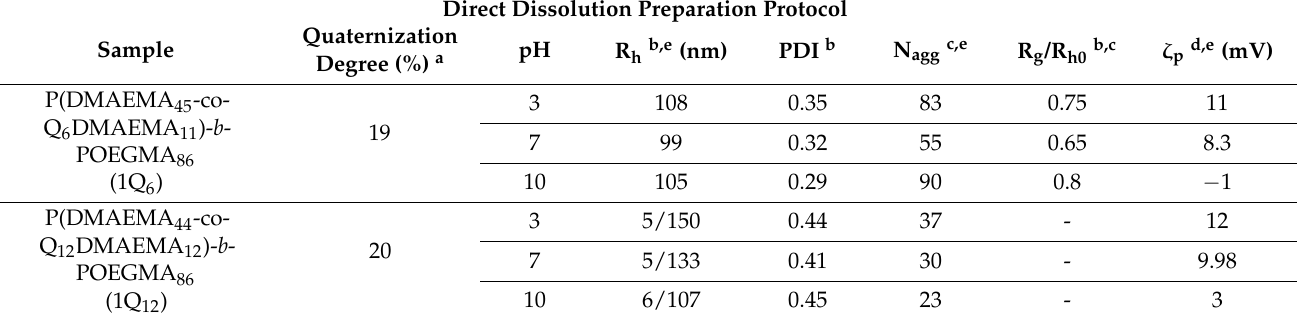
Physicochemical characteristics of P(DMAEMA 45 -co-Q 6 DMAEMA 11 )- b -POEGMA 86 and P(DMAEMA 44 - co-Q 12 DMAEMA 12 )- b -POEGMA 86 diblock solutions resulting from the direct dissolution protocol at different